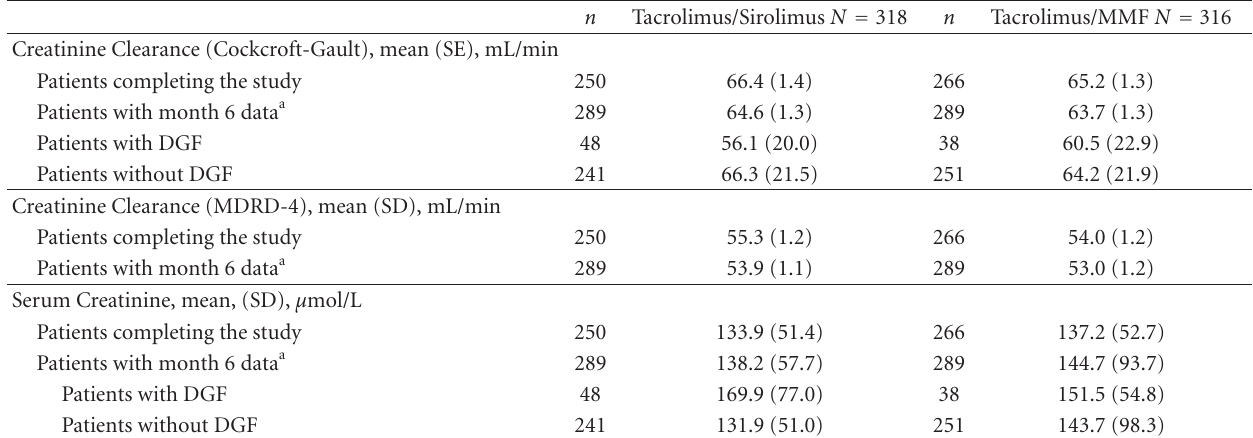
Table 2: Measurements of renal function at month 6.